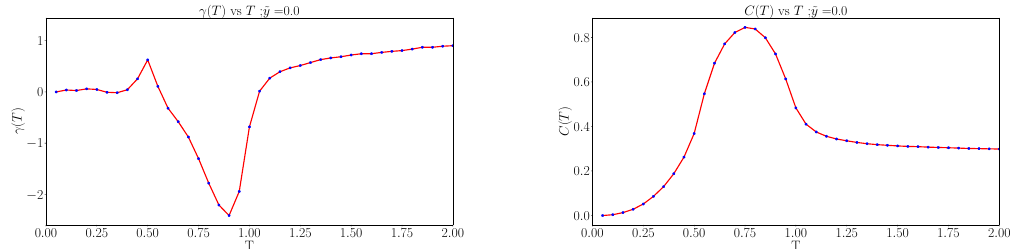
Figure 9 . The (cid:12)tting of I ( X ; Y; T ) to C ( T ) N + (cid:13) ( T ) for ~ y = 0. The data is obtained from (cid:12)tting lattice sizes N = 8 to N =